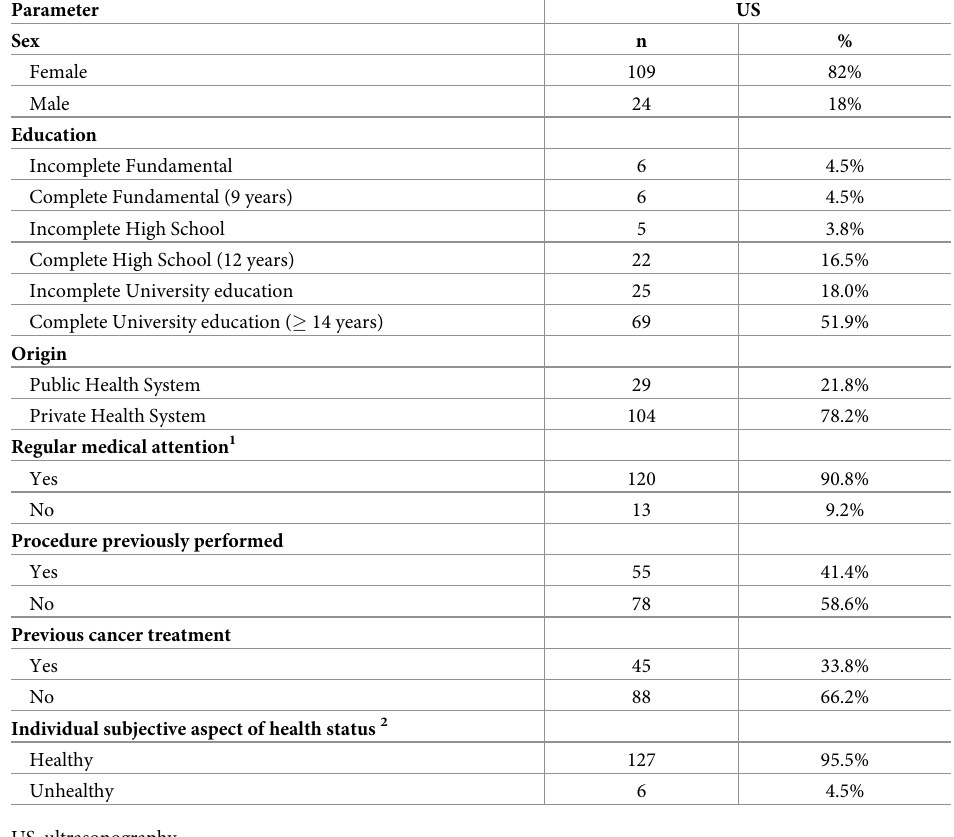
US, ultrasonography. 1 Patients asked if they considered themselves to have regular medical follow-up.